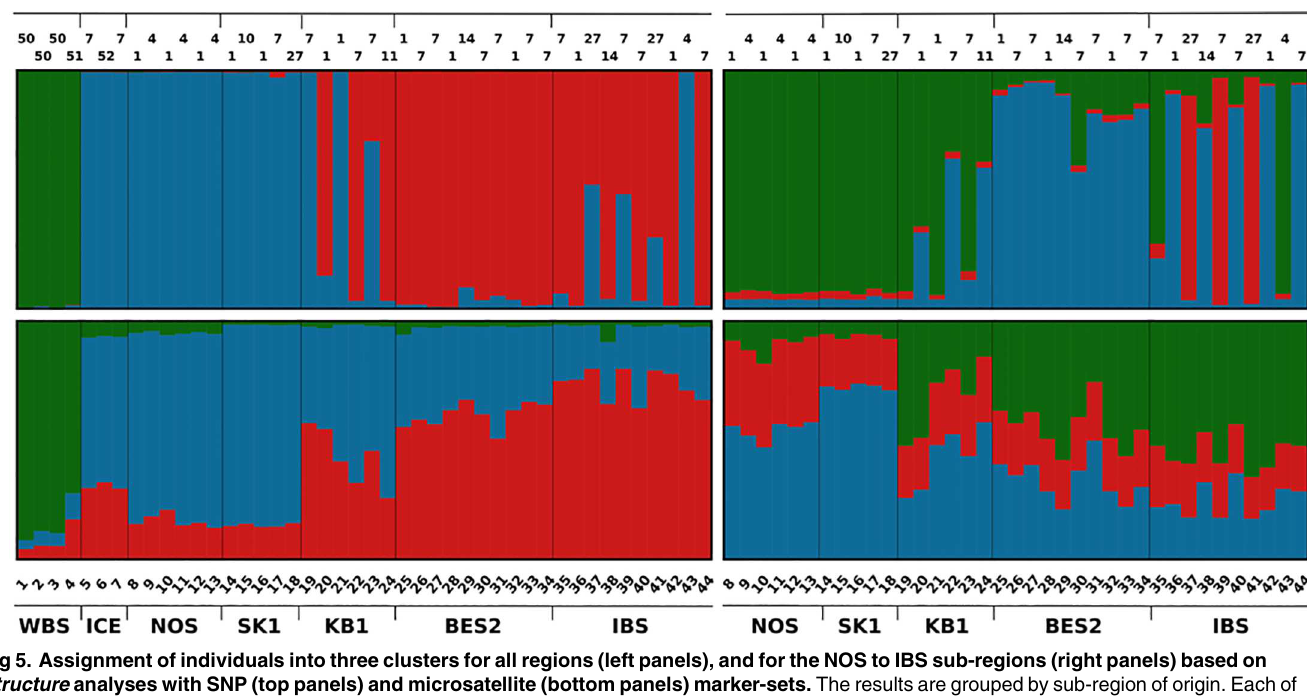
Fig 5. Assignment of individuals into three clusters for all regions (left panels), and for the NOS to IBS sub-regions (right panels) based on Structure analyses with SNP (top panels) and microsatellite (bottom panels) marker-sets. The results are groupedby sub-region of origin. Each of the 44 individualsis represented with a vertical column where the coloration is proportional to the individualsestimated membership coefficient in one of the given clusters of genetic similarity. Individuals’IDs are given belowthe plots with corresponding mitochondrial haplotypesabove the plots.